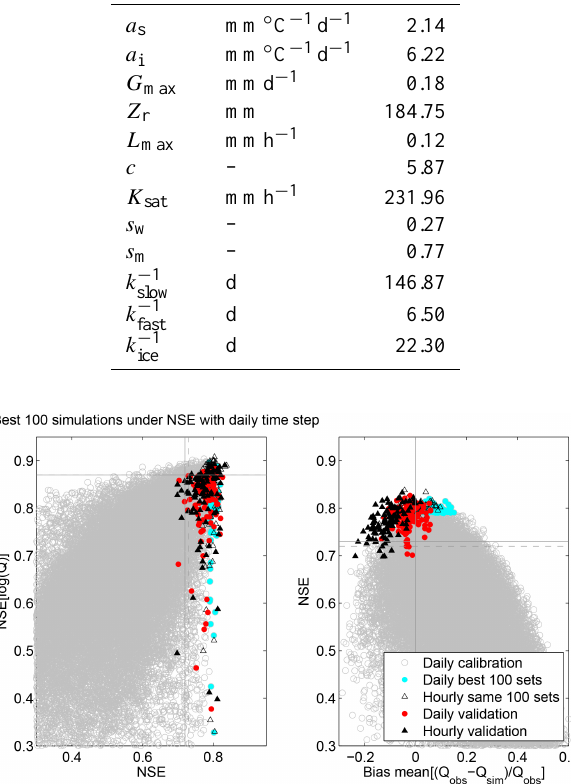
Figure 6. NSE vs. NSE-log for all simulated parameter sets during model calibration with daily time step (period 1981–1994), values for 100 parameter sets with best NSE values, values for the same parameter sets simulated over validation period (1993–2003) and values for the same parameter sets simulated at hourly time step over the validation period. The lines indicate the benchmark values for daily and hourly (broken line) time steps.